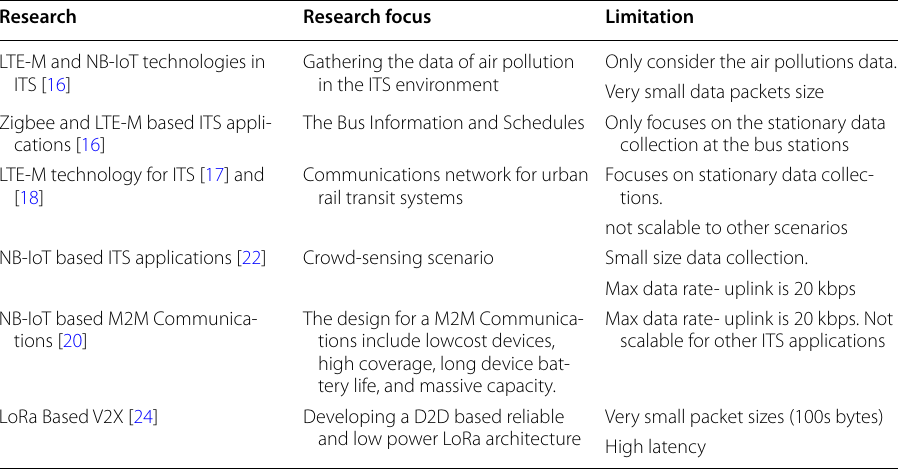
The design for a M2M Communica- tions include lowcost devices, high coverage, long device bat- tery life, and massive